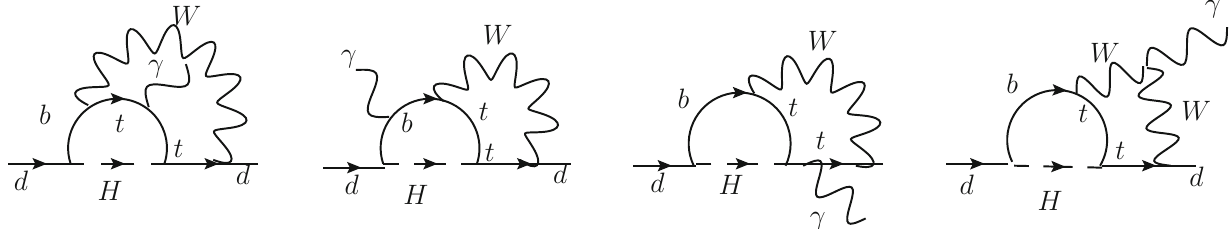
Fig. 2 ThreediagramswithFCHiggscouplingforEDMsofa d -quark. Soft photon emission from one of the charged particles is assumed to be added. The left diagram will give contributions suppressed by m u , d / M W . Taking the crossed diagrams in the center or to the right, we